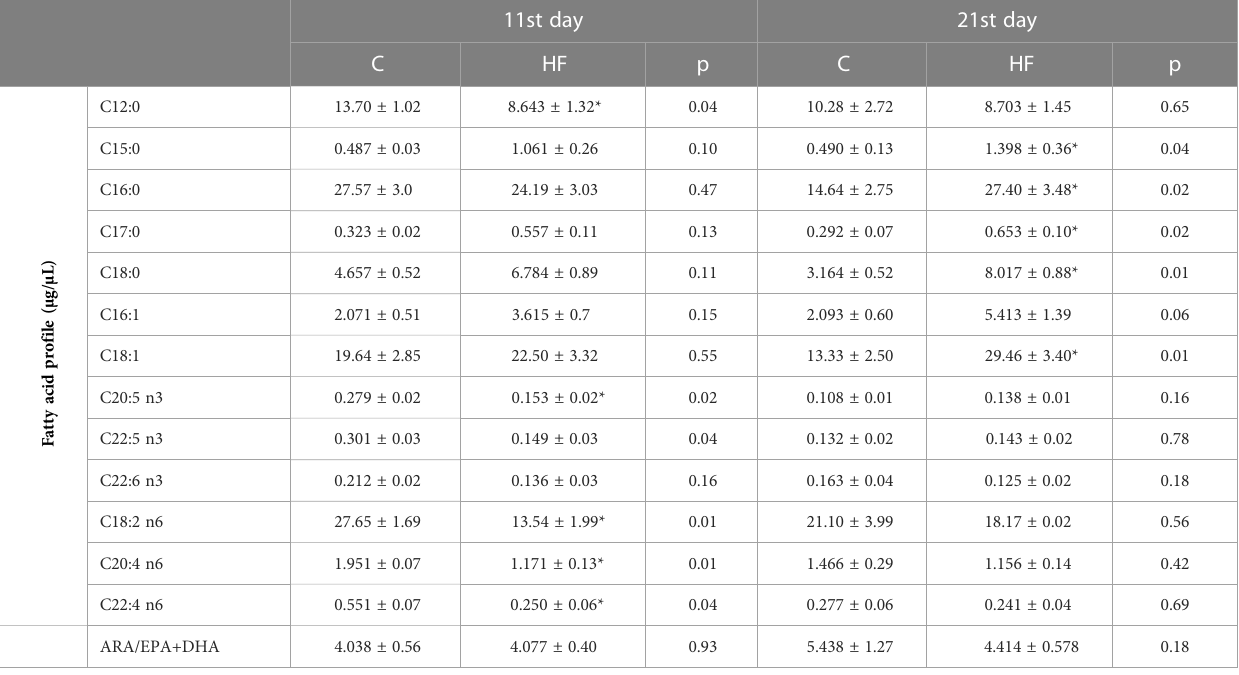
TABLE 4 Fatty acid pro fi le in breast milk of lactating rats at mid-lactation (11 st day) and late lactation (21 st day). 11st day 21st